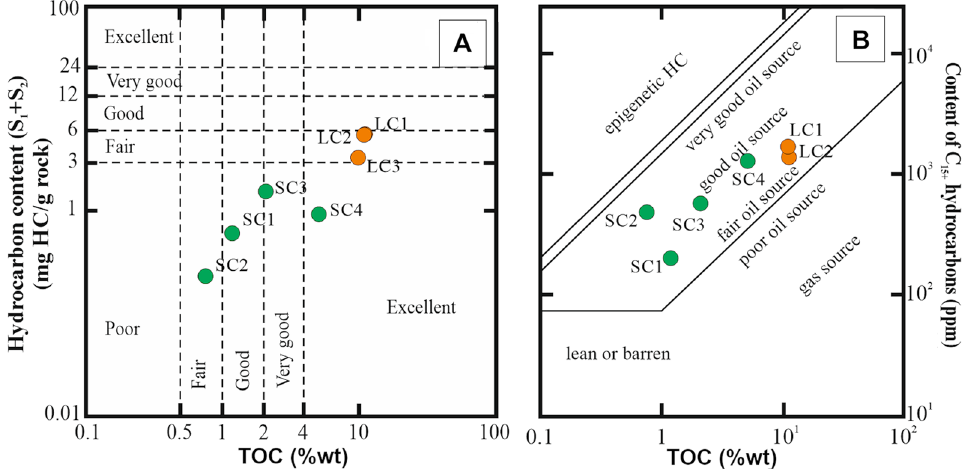
Figure 9. Petroleum source quality diagram for organic matter of La Toca and Yanigua formations. Petroleum quality classificationafter ( A ) Peters and Cassa 62 , ( B ) propose omit Hunt 63 and Leenheer 64 .